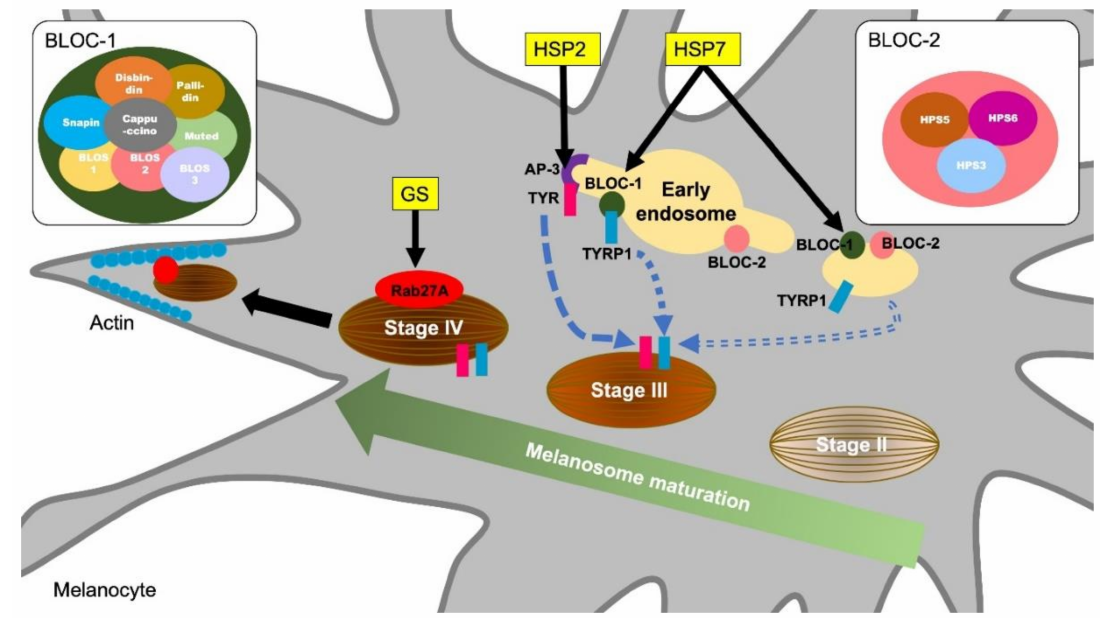
Figure 1. Molecular mechanisms of melanosome formation and maturation related to the hypopigmentary genetic diseases. Griscelli syndrome (GS) is an autosomal recessive disorder characterized by immunodeficiency and partial bleaching due to abnormal melanosome distribution. One of the causes of GS is a mutation in the Rab27A gene. Rab27A transports melanosome to the cell periphery, and Rab27A gene mutations result in a melanosome transport disturbance in melanocytes. Hermansky–Pudlak syndromes (HPS) are also rare autosomal recessive disorders and are associated with skin depigmentation and immune impairment. HPS2 patients have a deficiency in the β 3A subunit of AP-3. AP-3 classifies the melanin synthesis-related enzyme tyrosinase (TYR) from endosomes to melanosomes. Patients with HSP7 do not express the dysbindin protein, one of the components of BLOC-1 (biogenesis of lysosome-related organelles complex 1). BLOC-1 regulates the transport and biosynthesis of lysosomal organelles. BLOC-1 interacts with AP-3 to promote the transport of tyrosinase-related protein 1 (TYRP1). BLOC-1 also interacts with BLOC-2 and promotes TYRP1 transport by a mechanism di ff erent from that of